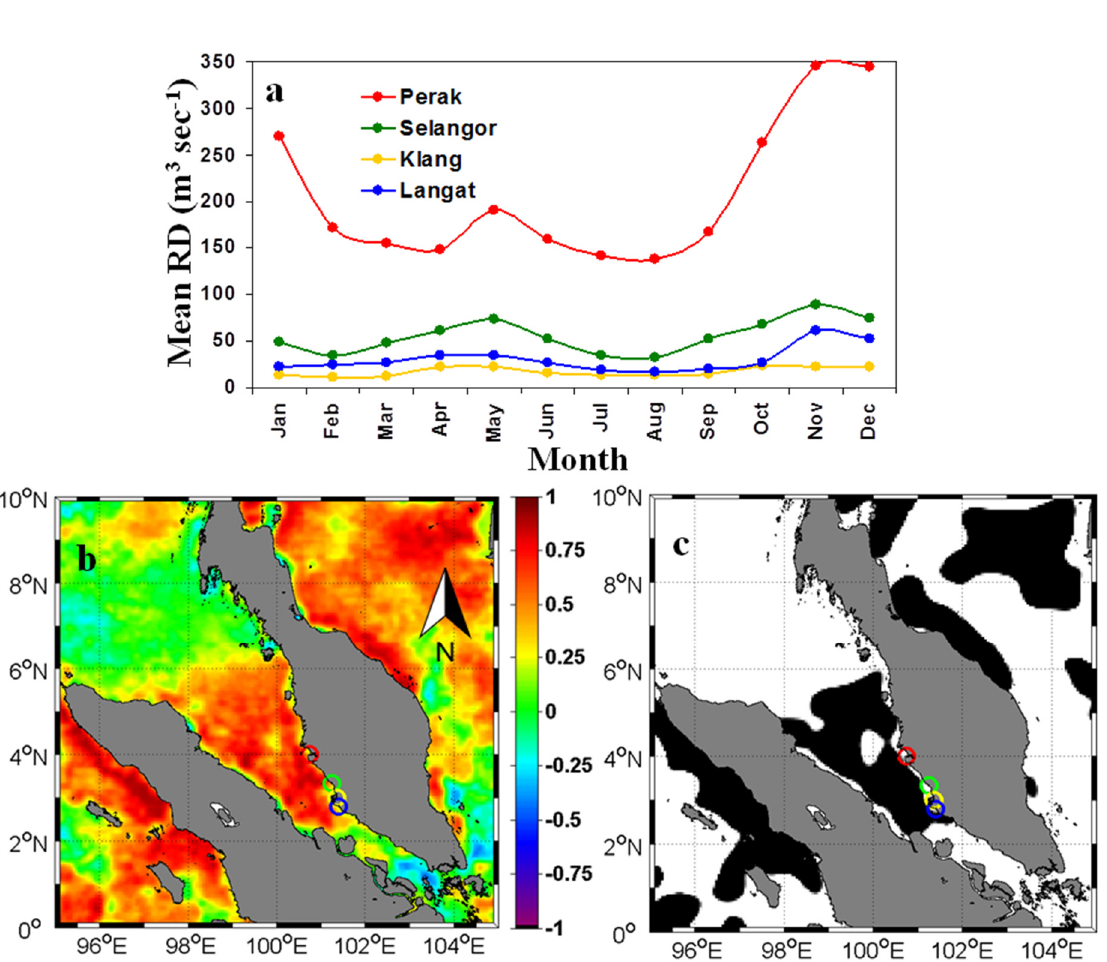
Figure 7. ( a ) Climatological values of river discharge (RD) into the SM from the Perak, Selangor, Klang and Langat Rivers. Panels ( b , c ) are, respectively, the spatial variation of the correlation coefficient ( r ) and the corresponding p -value ( p ) derived from linear regression of monthly climatological SeaWiFS chlorophyll- a concentration on monthly climatological RD averaged for the four main rivers (Perak, Selangor, Klang and Langat Rivers). The black area in panel (c) is the area of r with p < 0.05, the indication being that the correlation was significant. Red, green, yellow and blue circles in (b,c) indicate, respectively, the estuaries of the Perak, Selangor, Klang and Langat